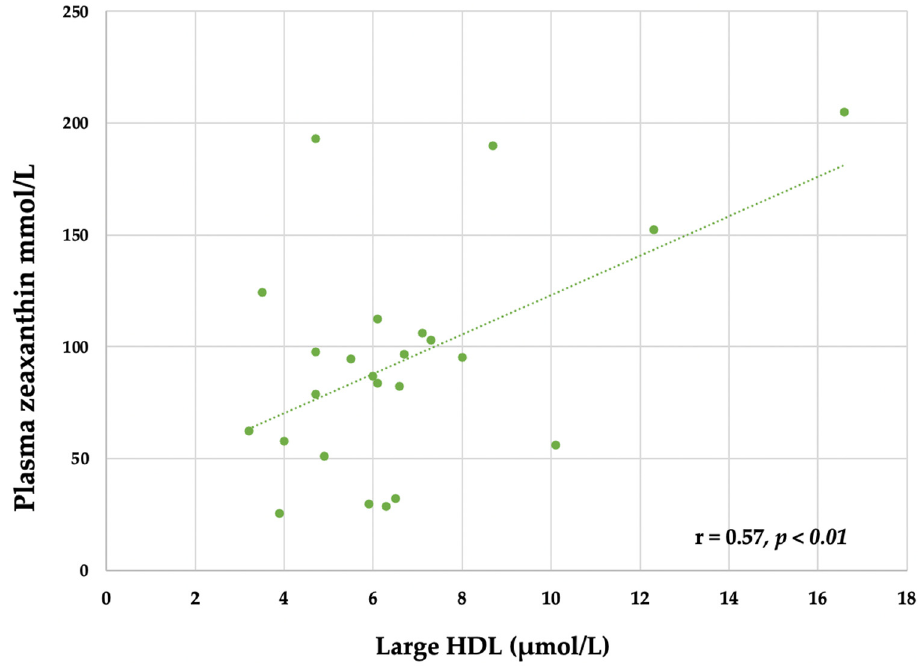
during the EGG period (r = 0.57, p < 0.01) (Figure 4). This was a strong correlation since the r was almost equal to 0.6 in a group of 24 participants.